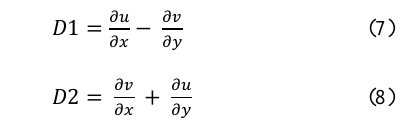
Table 1. d/dx kernel